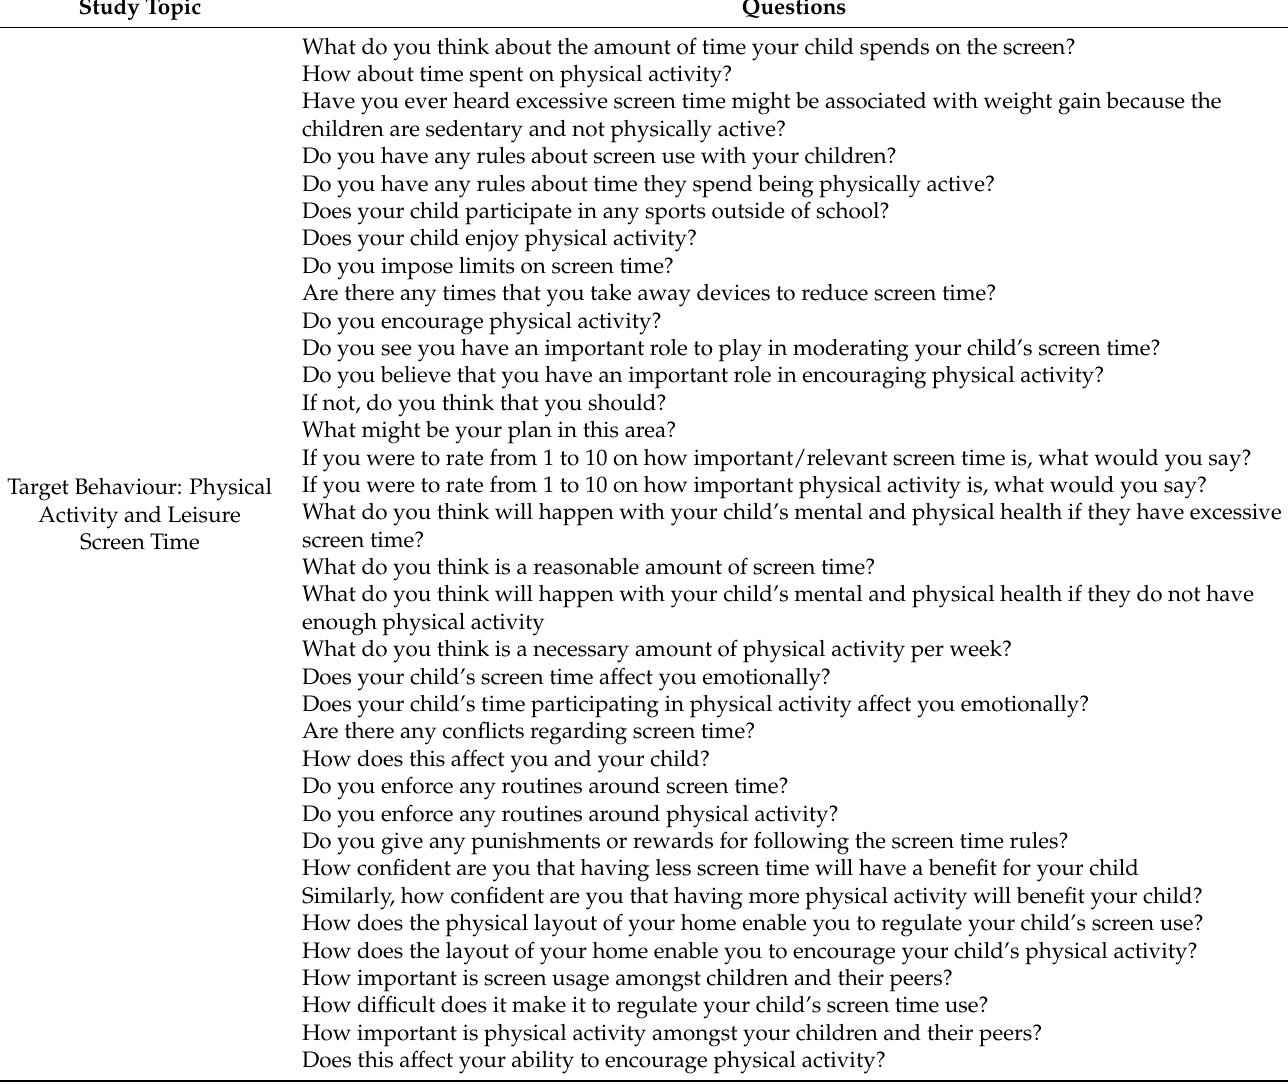
Table 2. Questions used in interviews to gather information on the capabilities, opportunities, and motivations of parents on adolescent physical activity and screen time behaviors. Study